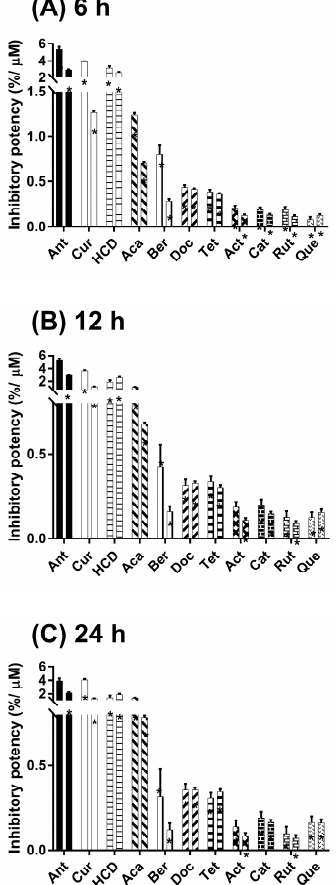
Figure 2. Inhibitory effect of test compounds on the in vitro maltose digestion. Caco-2 cells were treated with test compounds (acarbose (Aca) 40 or 80 µM; antroquinonol (Ant) 5 or 10 µM ; catechin